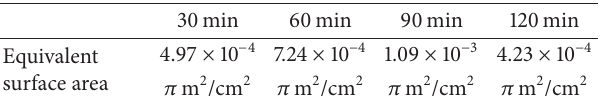
Table 1: Equivalent surface area of ZnO nanowires on 1 × 1cm 2 FTO glass with different growth time.